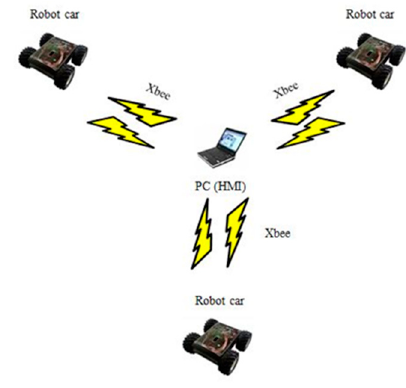
Figure 2. The full system.